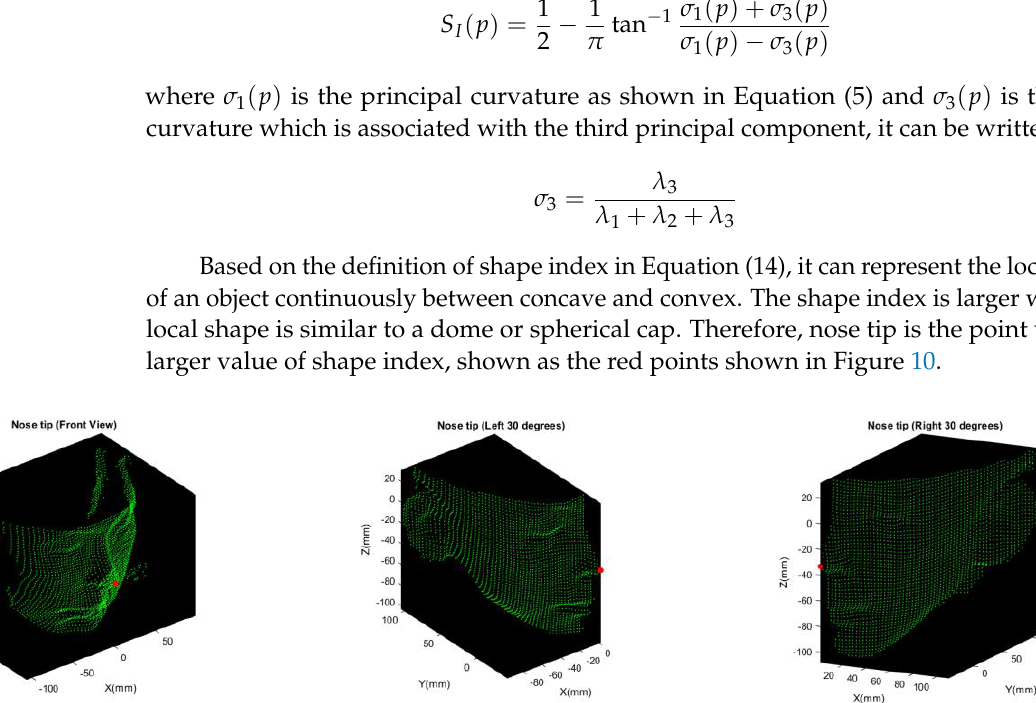
( d ) Figure 9. Precise segmentation by K-means clustering: ( a ) head point cloud of Model 1; ( b ) head point cloud of Model 2;